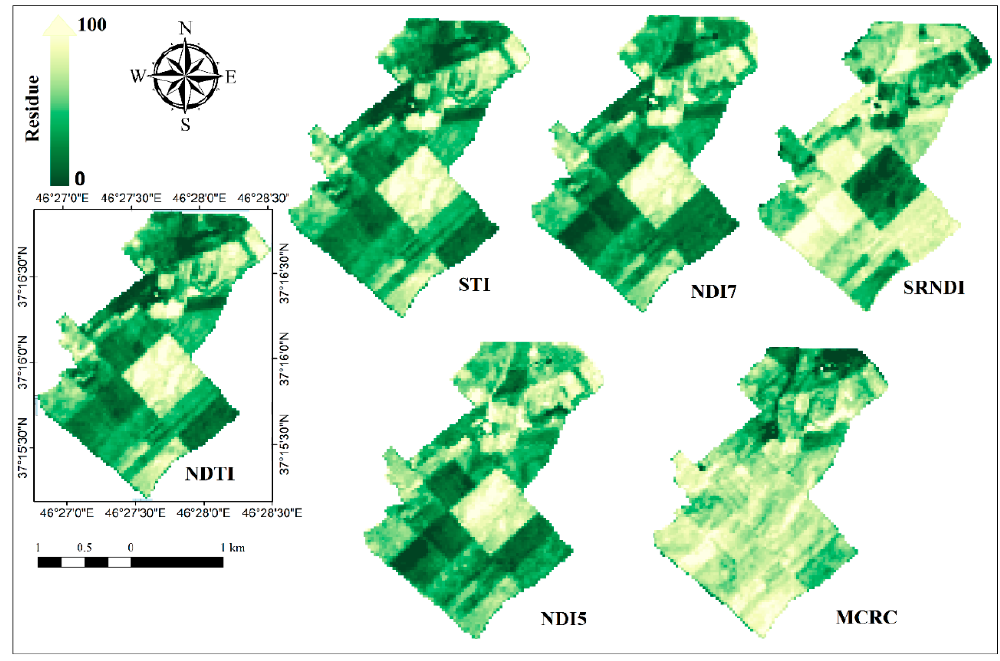
Figure 5. SSR maps of Landsat-8 based indices.